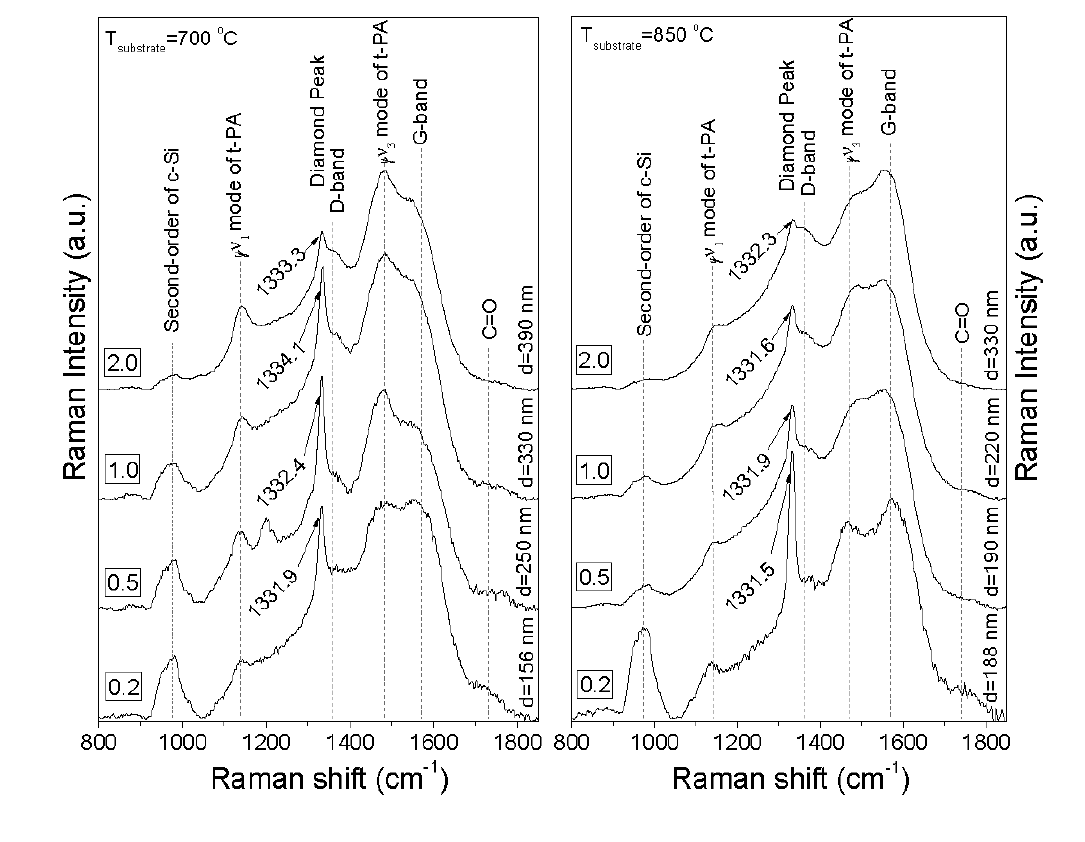
Figure 3: 488 nm excited Raman spectra of the NCD films prepared under different